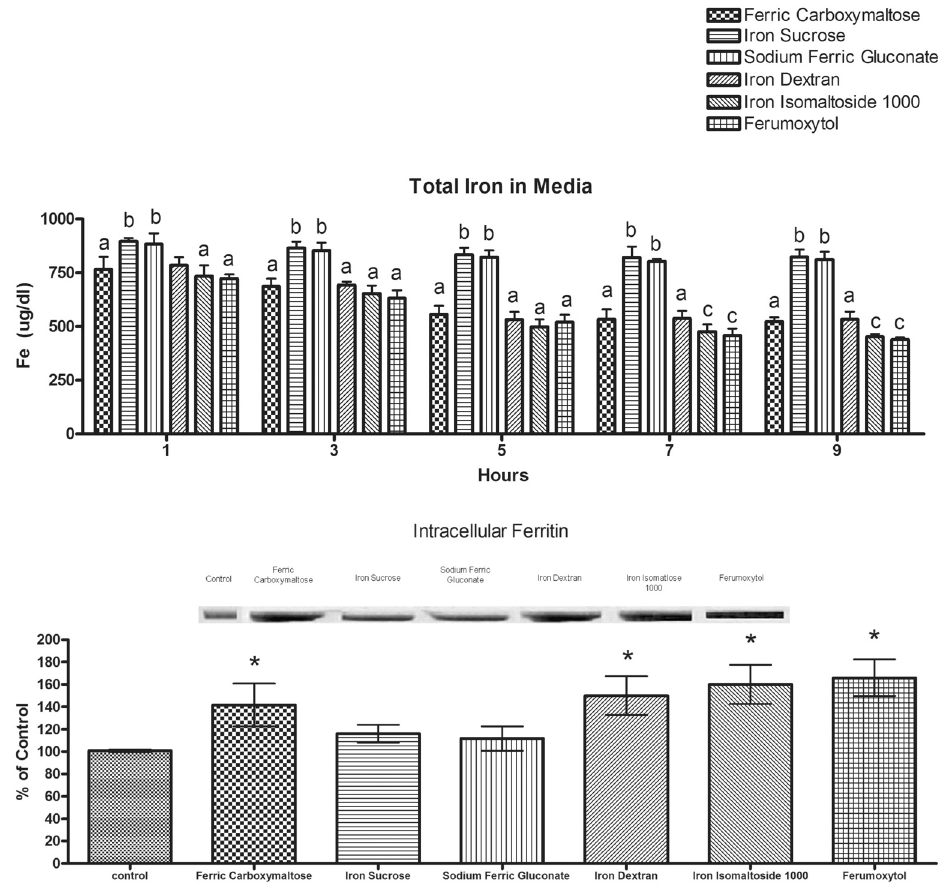
Fig 6. Total iron content in media and the content of H-ferritin in primary peritoneal macrophages after exposure to the iron formulations. Rat peritoneal macrophages were obtained by peritoneal lavage. The cells were exposed to 0.1 mg/ml of elemental iron for each of the iron formulations for 24 hours. The media was then monitored for presence of total iron by removing 50uL aliquots from the media over 9 hours. The top figure (A) shows total iron in the media was highest (indicating decreased uptake) for iron sucrose and sodium ferric gluconate (b = not statistically significantly different) at all time points. The other compounds were similar (a) until 7 hours when iron uptake was assessed greater for iron isomaltoside and ferumoxytol (c). There is almost no loss of iron from the media over the time monitored for iron gluconate or